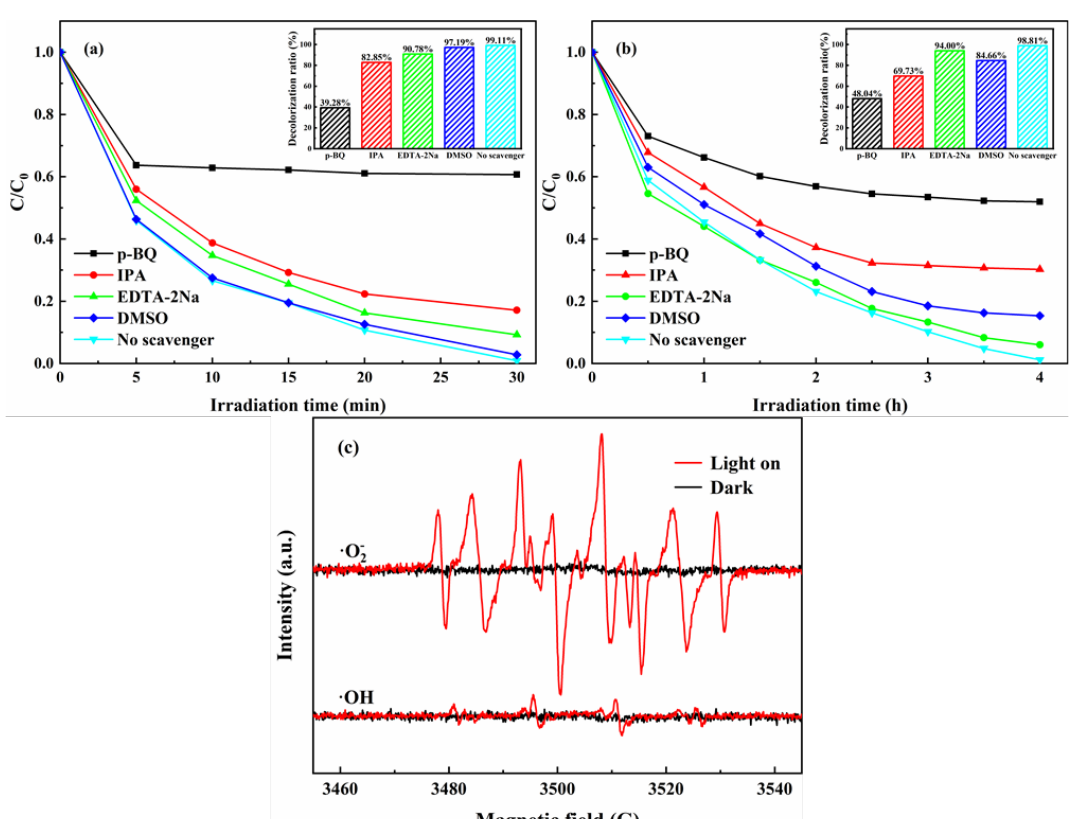
Figure 12. Photodegradation performance of RhB and MO using different radical scavengers over